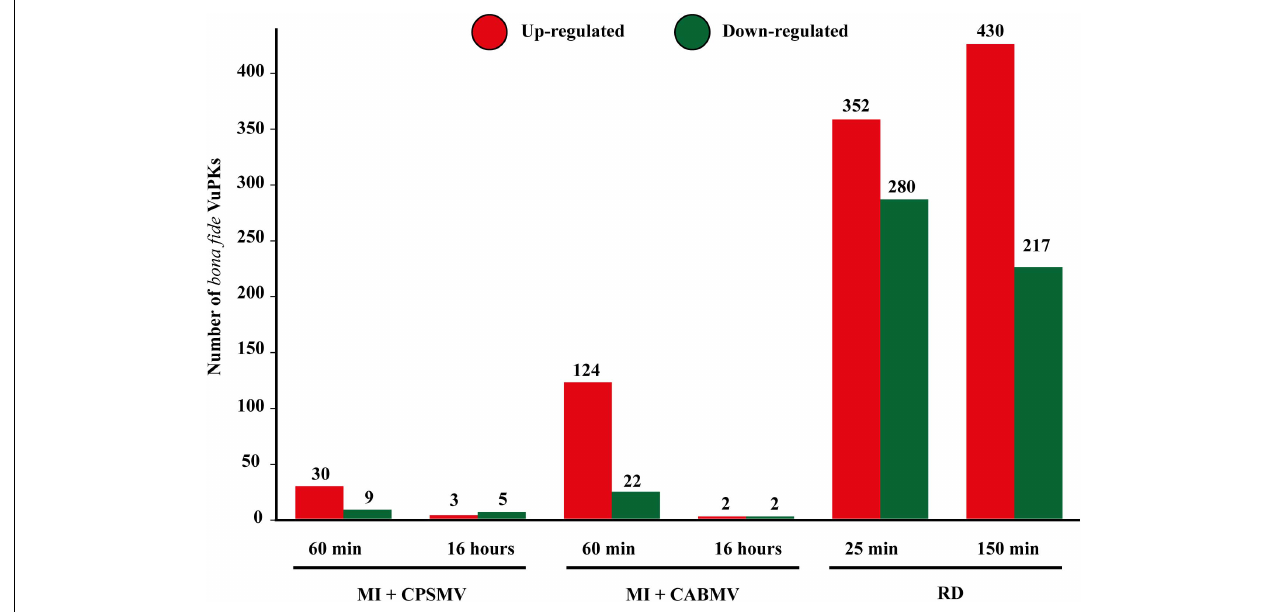
FIGURE 7 | Amounts of bona fide VuPKs differentially expressed in the studied treatments. VuPKs, Vigna unguiculata protein kinases; MI, mechanical injury; CABMV, cowpea aphid-borne mosaic virus; CPSMV, cowpea severe mosaic virus; RD, root dehydration; min,